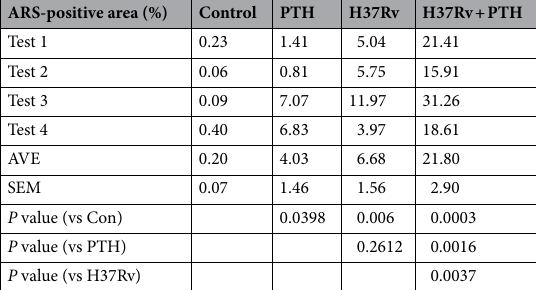
Table 3. Alizarin red S (ARS) staining result.